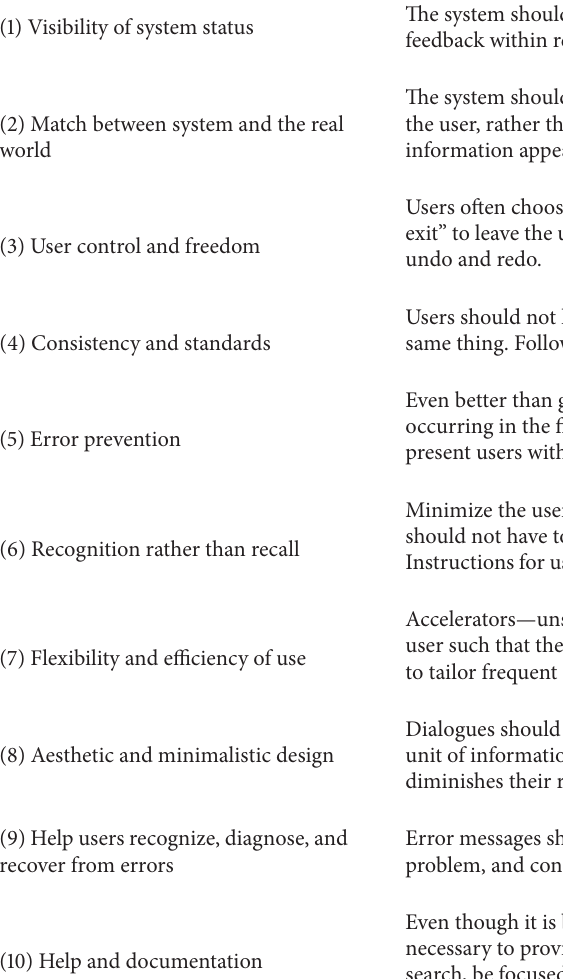
Table 1: Jakob Nielsen’s ten heuristics, including a description of each heuristics. Jakob Nielsen’s ten heuristics